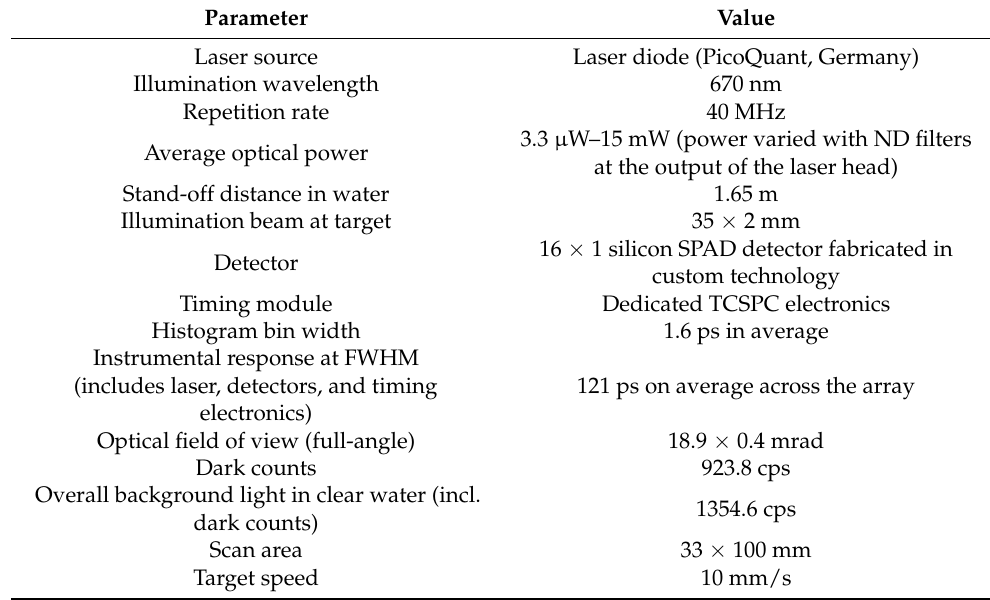
Table 1. Main parameters of the experiments.